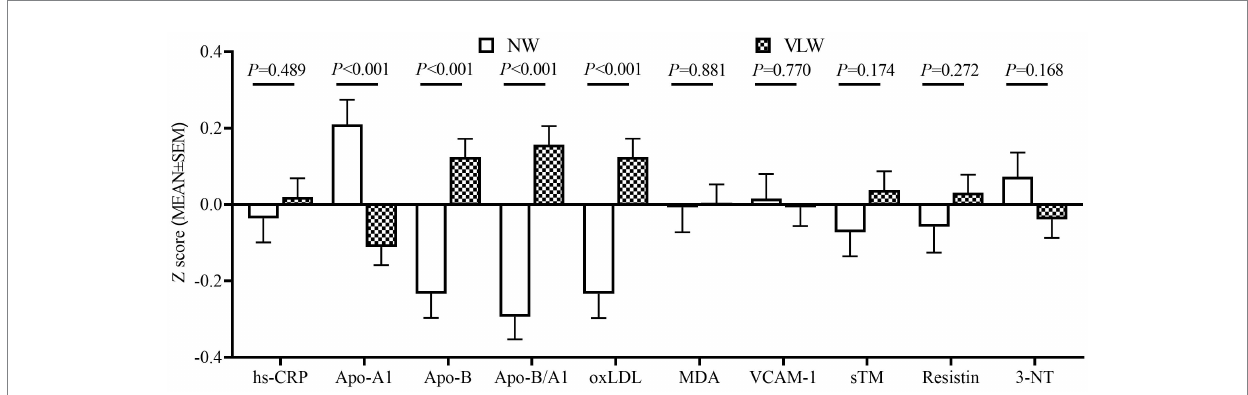
FIGURE 2 Comparison of serum biomarkers of the cardiovascular system between the two groups after consumption of DDW in children. Values were age- and sex-specific Z-scores (means ± SEM, NW: n = 229, VLW: n =